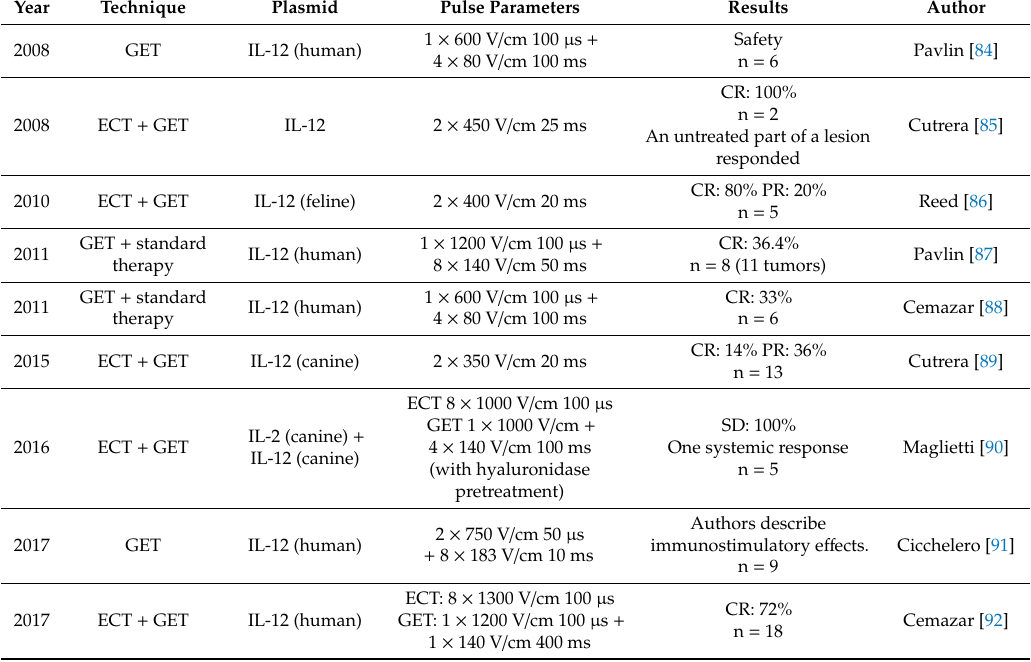
Table 2. Summary of research articles published using Gene electrotransfer (GET) alone or in combination with Electrochemotherapy (ECT), or other strategies for treating spontaneous tumors in canine patients. The reported species of the genes used is included in